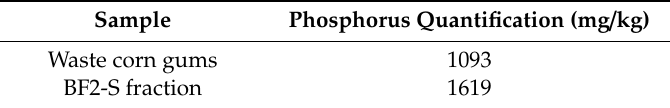
Table 1. Phosphorus content quantification in waste corn gums and BF2-S fraction.